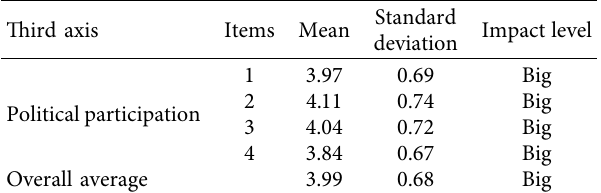
Table 7: Arithmetic averages and standard deviations of the fifth